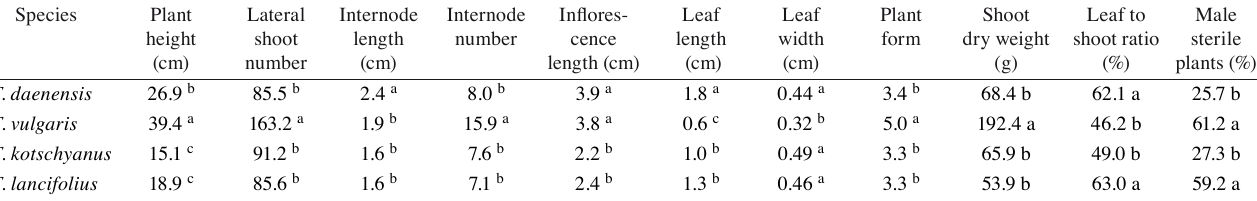
Tab. 3: Morphological traits in different Thymus species Species